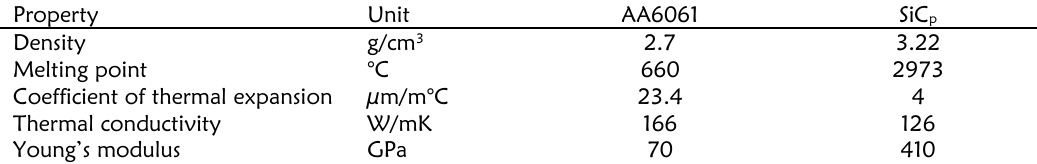
Table 2: Properties of AA6061 alloy and SiC p (Adebisi et al., 2017)